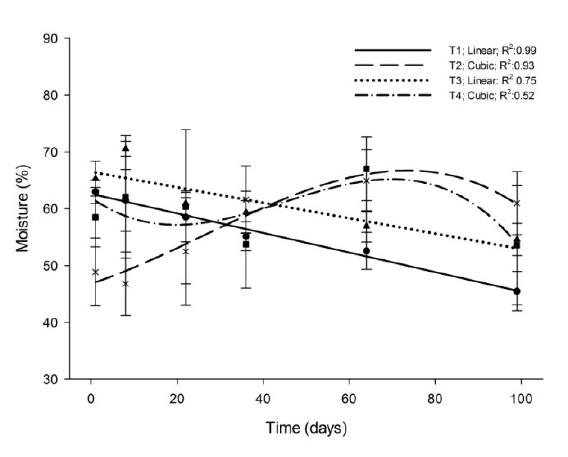
Figure 2: Moisture of static piles (T1 ● prickly pear cactus+BP; T2 ᵡ moringa+BP; T3 ▲ prickly pear cactus; T4 ▀ moringa) over 100 days of analysis. Means (±SD) were calculated from five replicates for each treatment and sampling day. Statistically different (Tukey test, p<0.05)